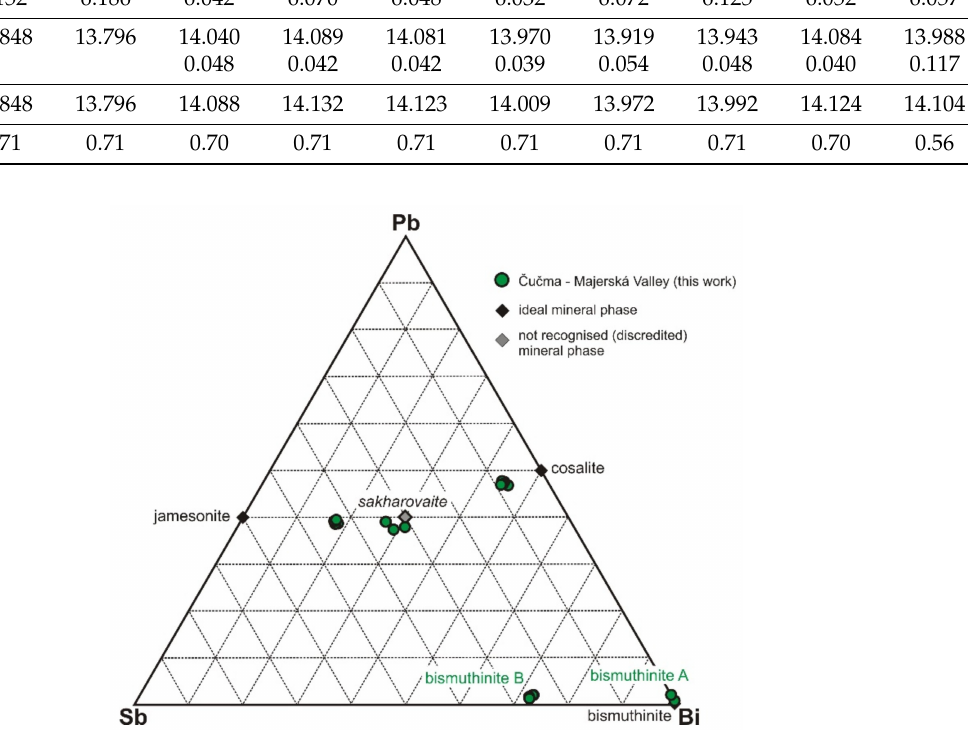
Figure 12. Chemical composition of bismuthinite, Sb-bearing cosalite and Bi-bearing jamesonite from ˇCuˇcma, in ternary system